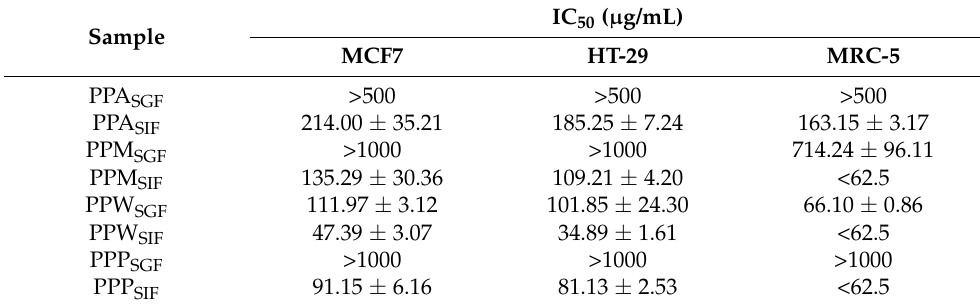
Table 4. Antiproliferative activity of four peach